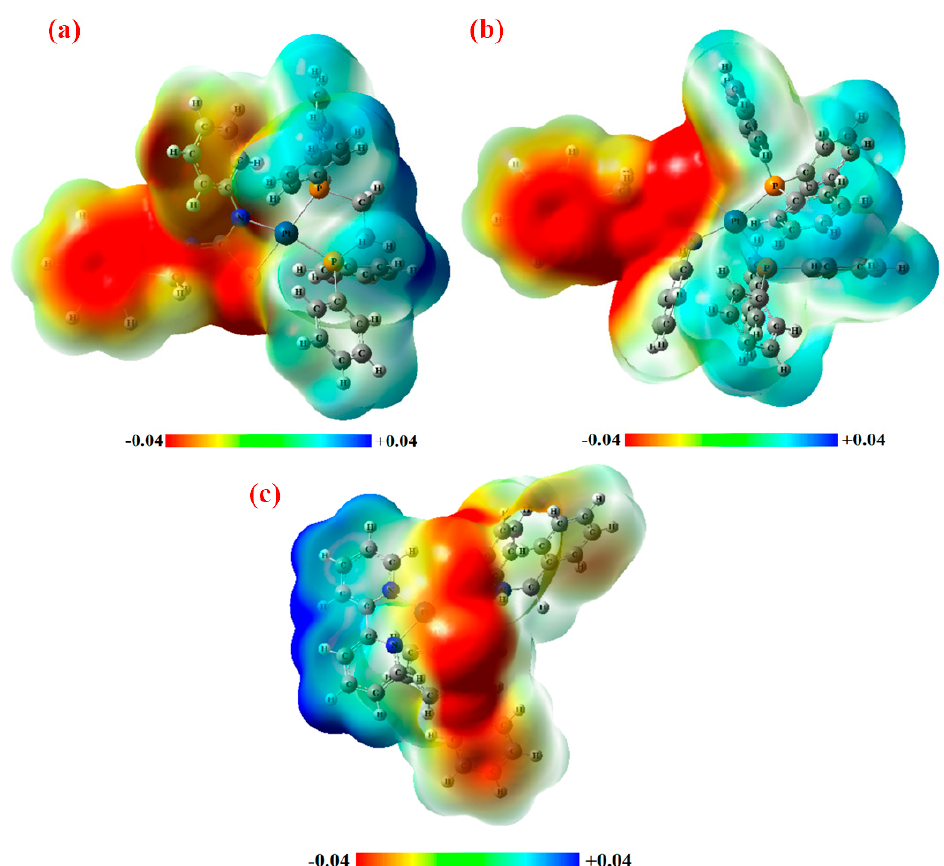
Figure 7. Molecular electrostatic potentials calculated at the level of B3LYP/Def2-TZVP for ( a ) [Pt(BPT)(dppe)] ( 1 ), ( b ) [Pt(BPT)(PPh 3 ) 2 ] ( 5 ), and ( c ) [Pt(BPT) 2 (Bipy)] ( 7 ).